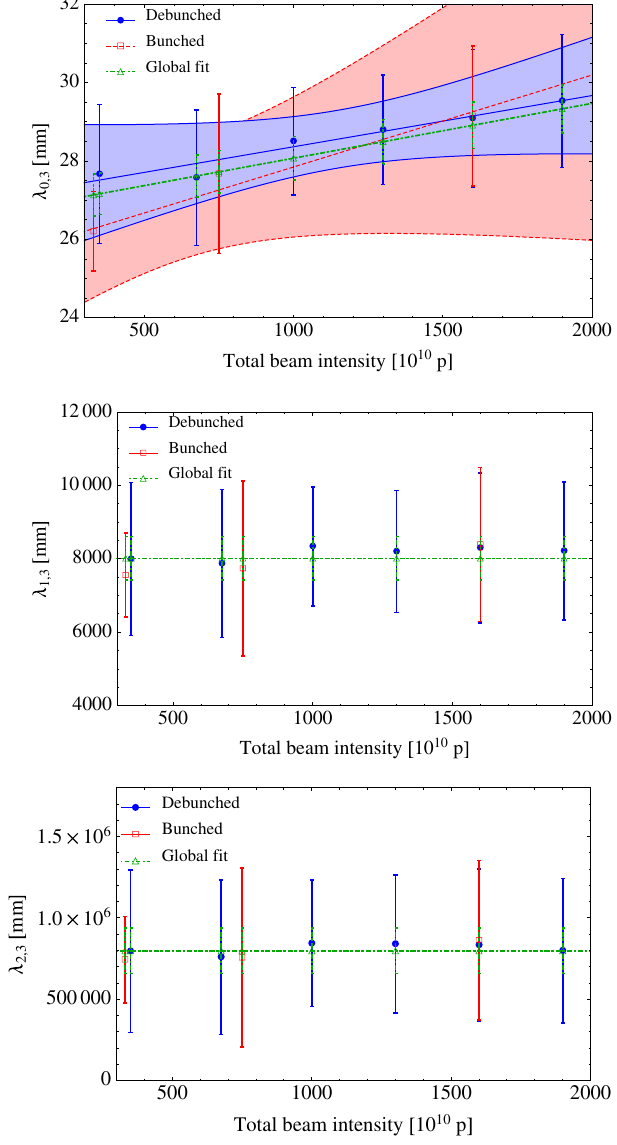
FIG. 15. Dependence of the quadratic fit parameters (cid:11) i; 3 on the beam intensity. The unconstrained fit parameters together with the global one (green lines) are shown. The shaded areas in the plot of (cid:11) 0 ; 3 represent the prediction bands around the estimated linear fit lines at 95% confidence level. The straight line obtained for the global fit is in the intersection of the bands for the debunched and bunched beams